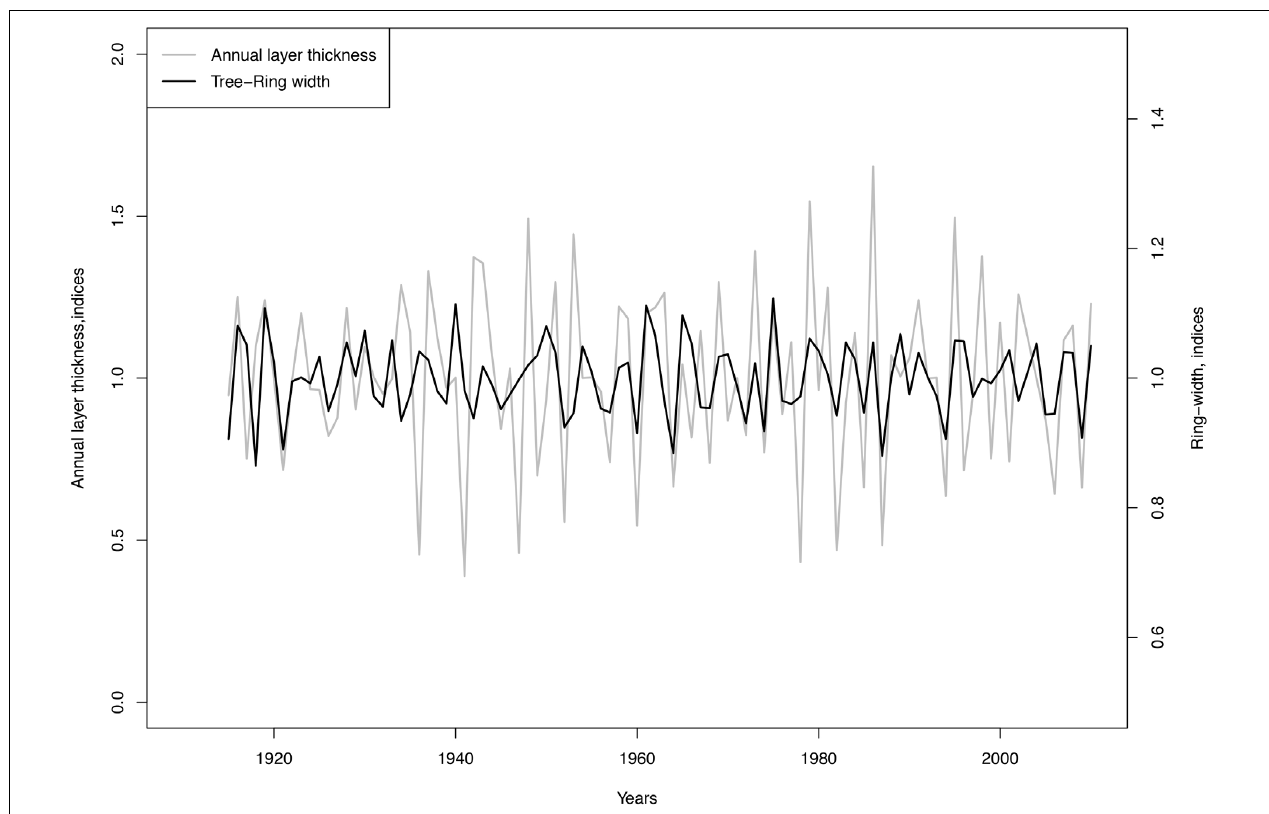
FIGURE 8 | Comparison of the detrended series of annual layer thickness (calculated as distance between Rb/Sr peaks) and TRW indices of the site D09S.